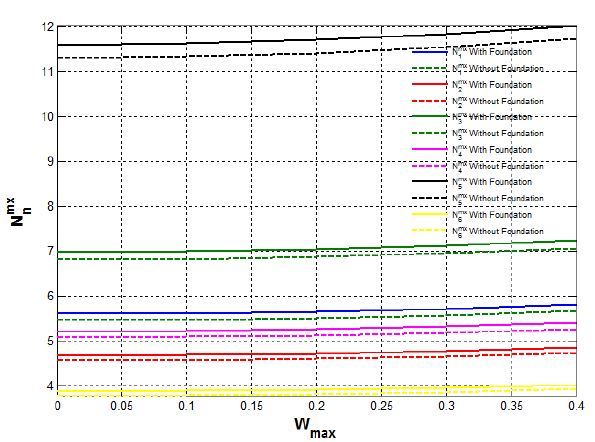
Figure 7: Variation in nonlinear critical buckling load with respect to foundation under varying inplane loading